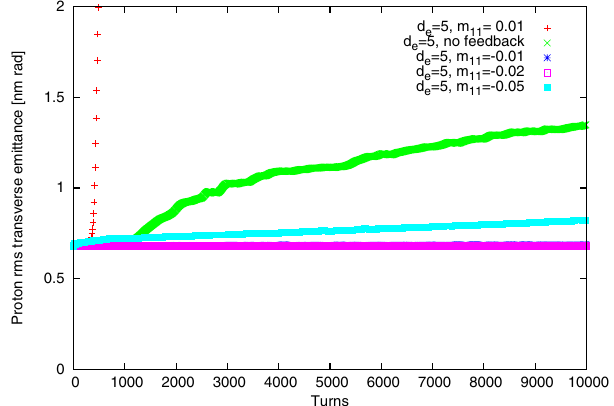
FIG. 9. The effect of the feedback system with or without the transverse damper at disruption parameter 20.